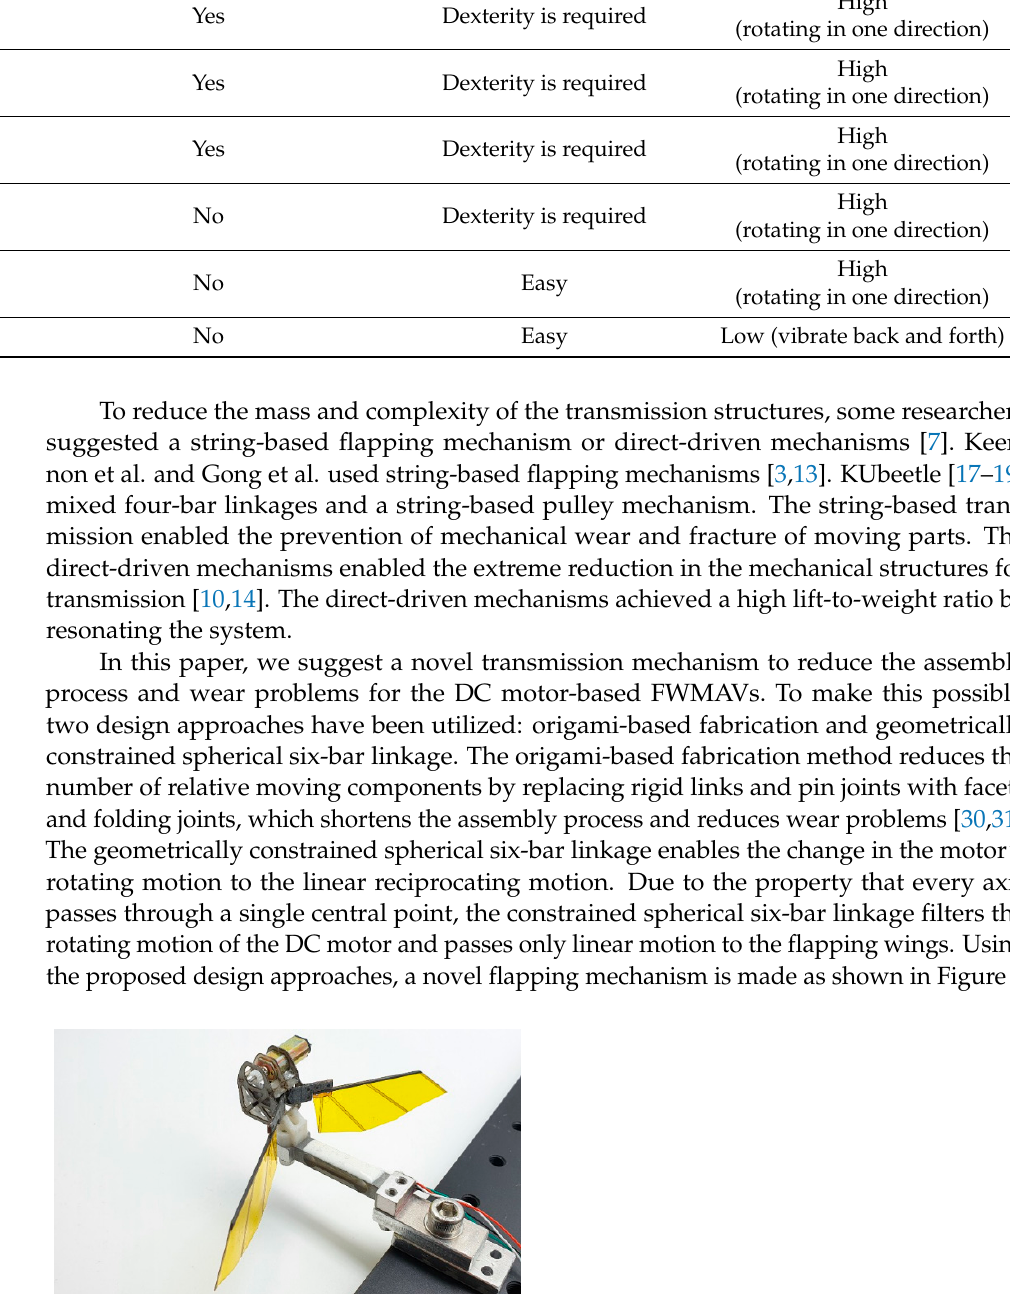
Table 1. Transmission mechanisms used for DC motor-based flapping-wing micro air vehicles (FWMAVs). Mechanism Types